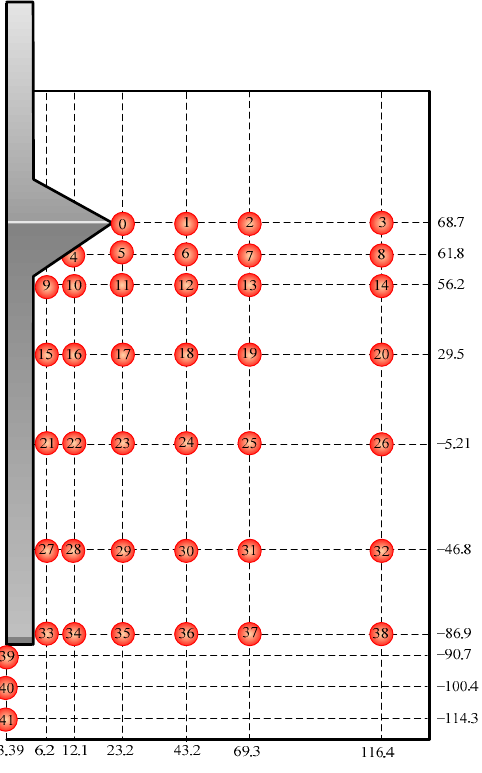
Figure 12. Data point distribution map.